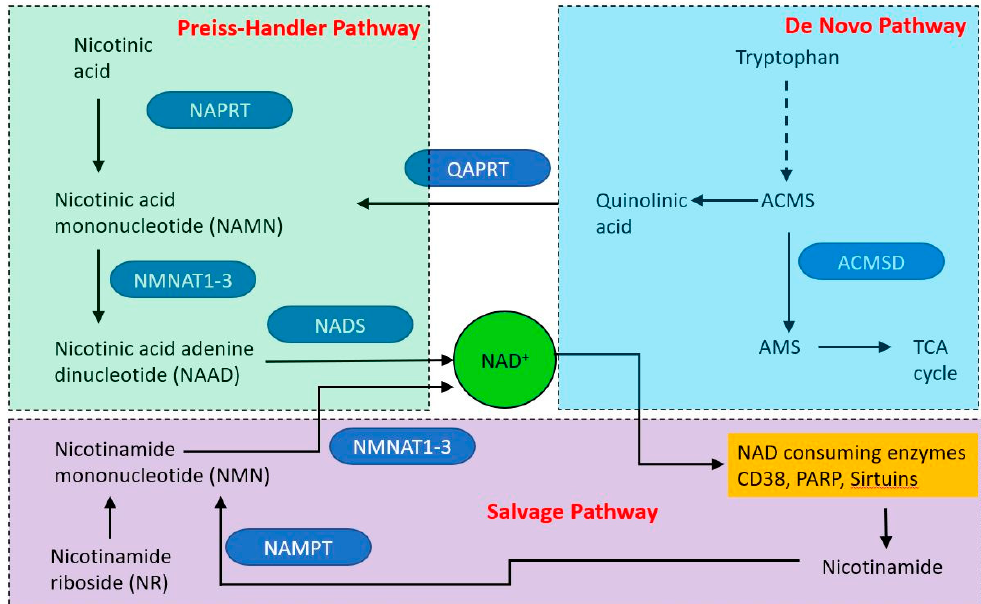
Figure 5. Overview of nicotinamide adenine dinucleotide (NAD) synthetic pathways. Three major pathways produce NAD, two from dietary starting points and one (the salvage pathway) from nicotinamide derived from NAD catabolic pathways. Single step reactions are indicated by solid arrows, the dashed arrow indicates a series of reactions.